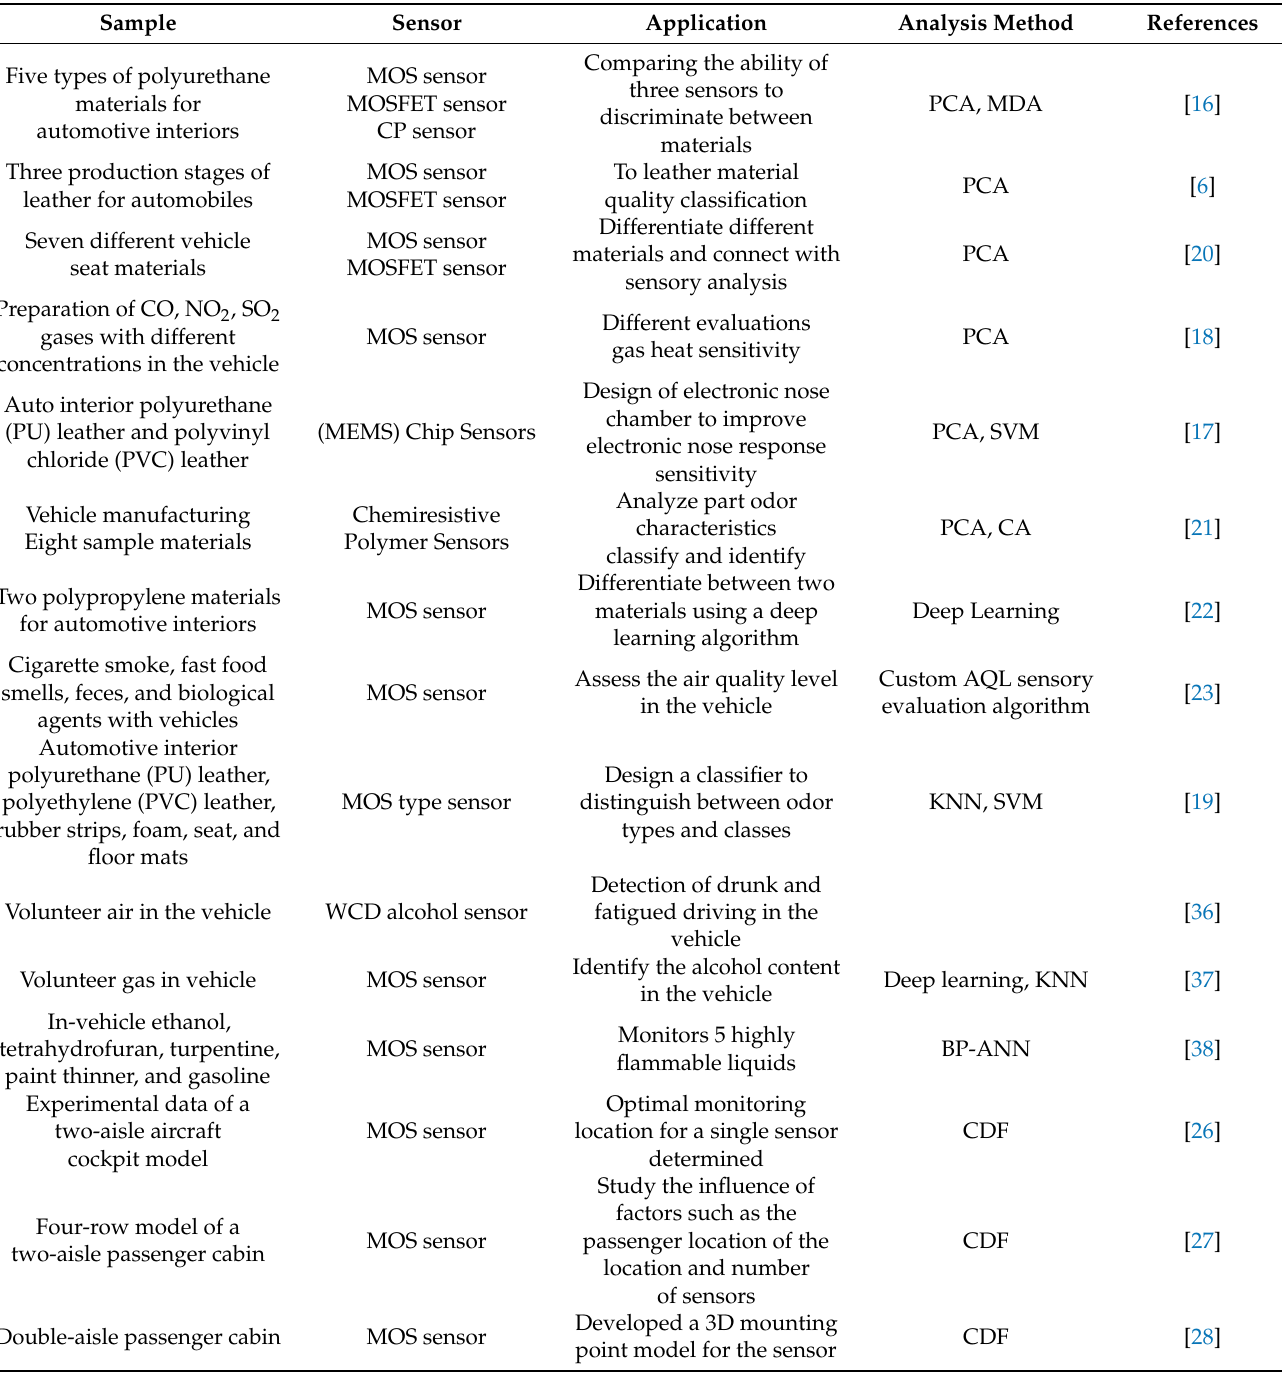
Table 2. Application of electronic nose in gas detection in closed